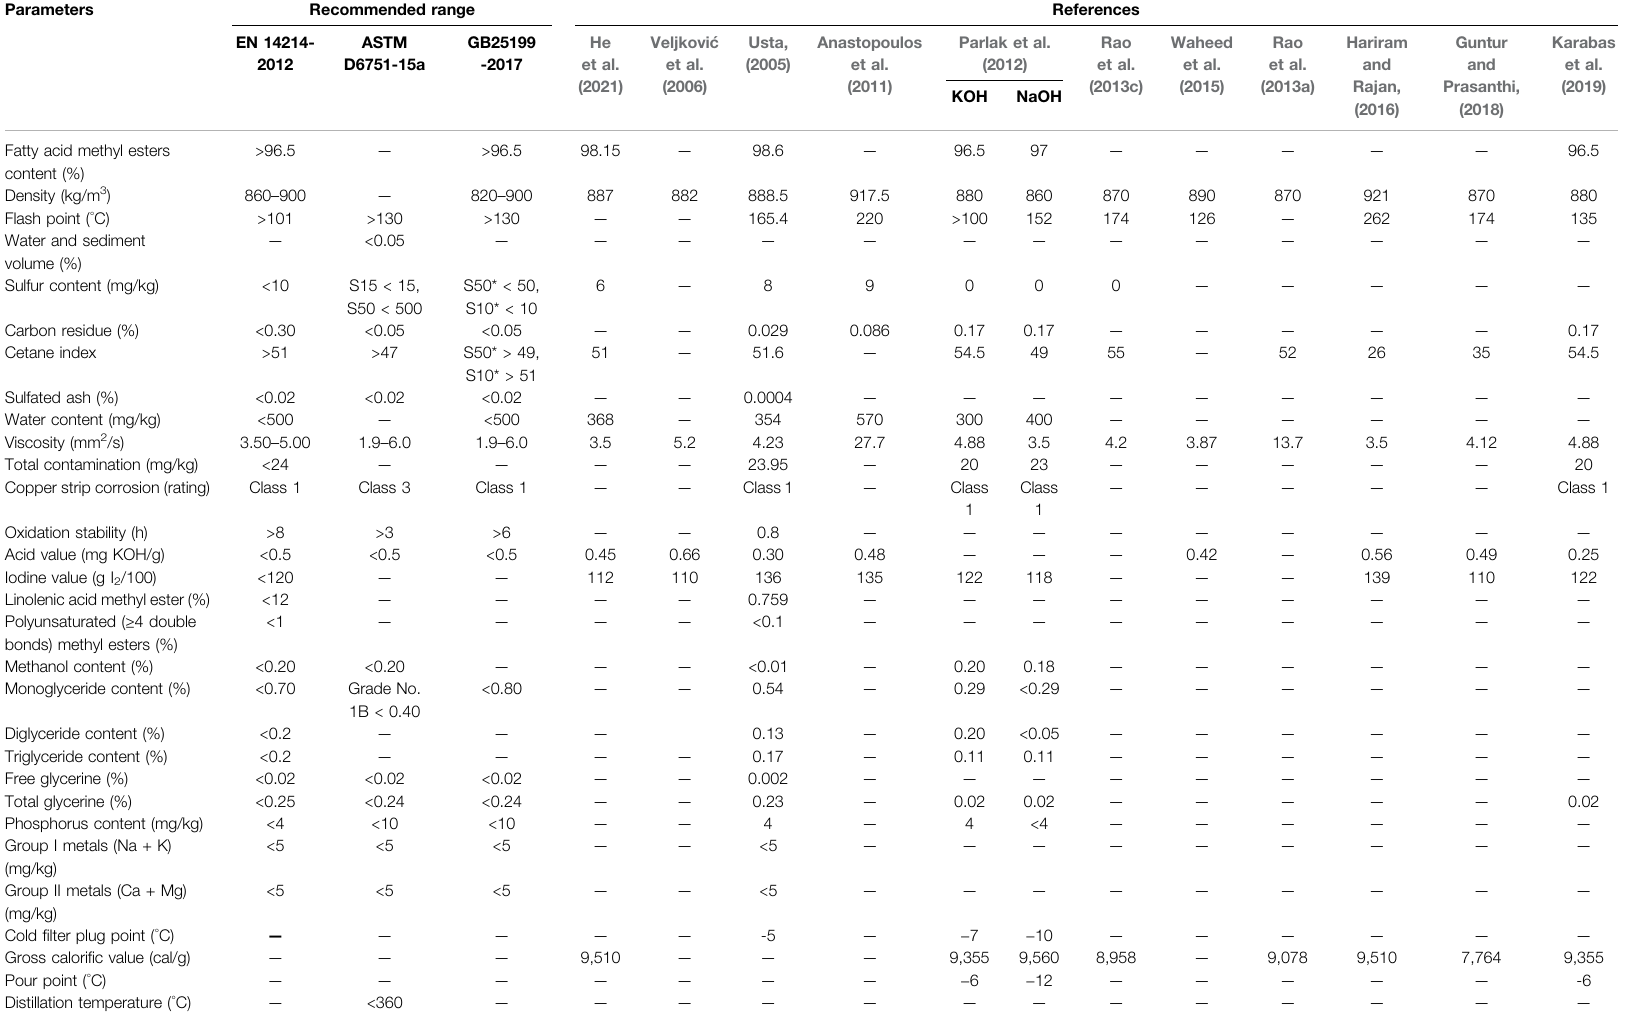
TABLE 3 | Comparisons of the properties of TSOBD under different standards.